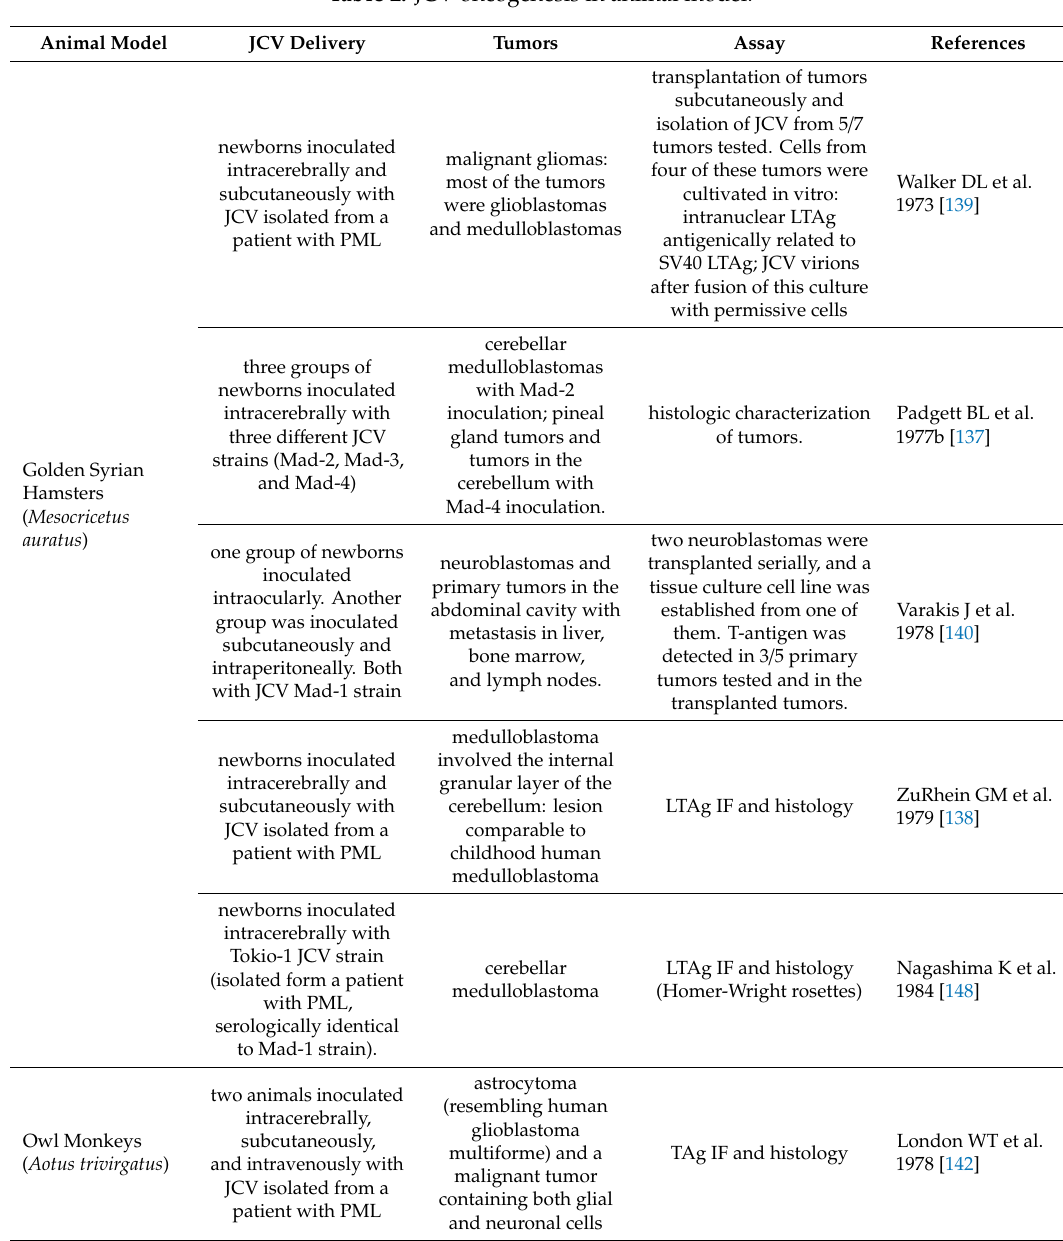
Table 2. JCV oncogenesis in animal